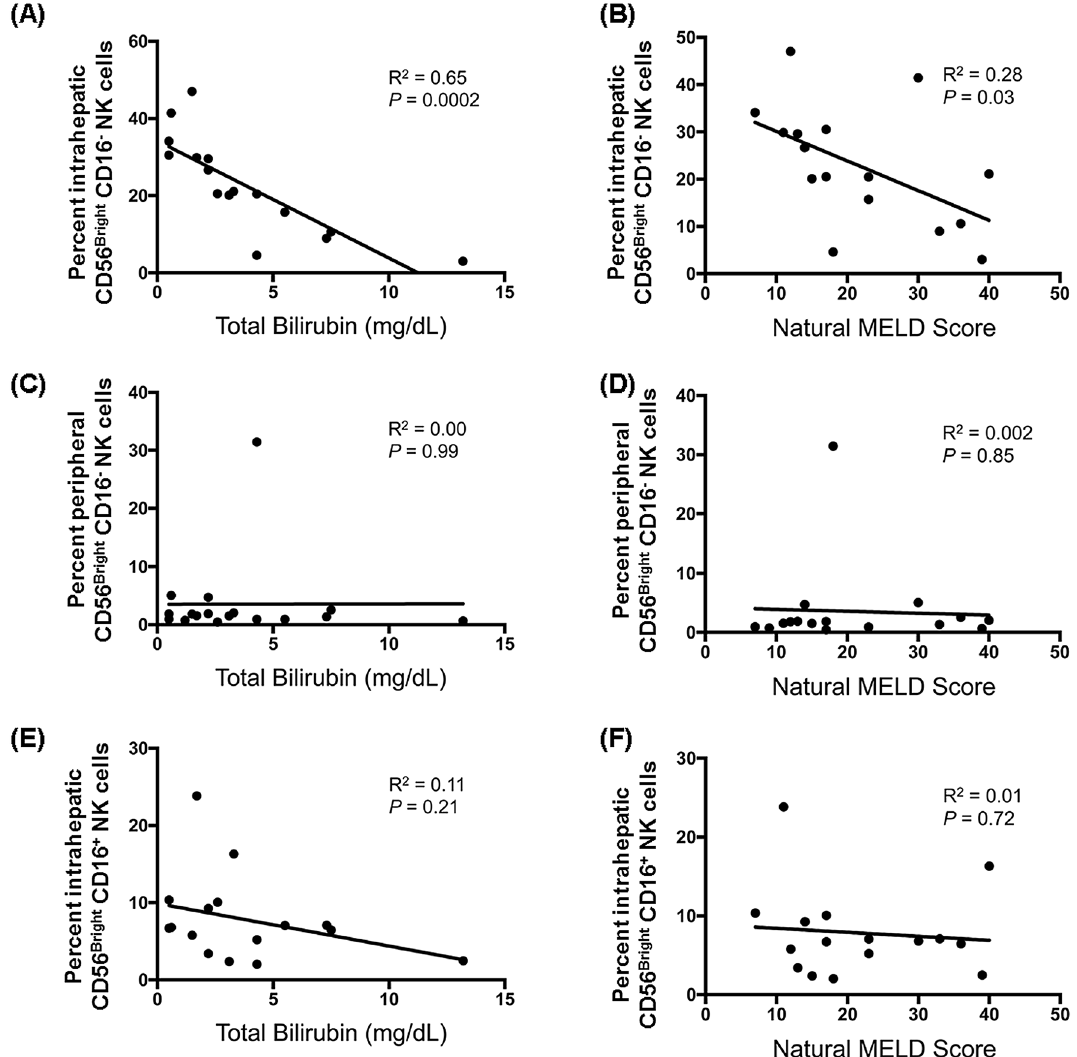
Figure 6. Correlation between the abundance of liver resident CD56 Bright CD16 - NK and better clinical status. The correlation between the abundance of hepatic CD56 Bright CD16 - NK cells and serum total bilirubin (A) and the natural MELD score calculated for the day of transplantation (B) . The correlation between the abundance of peripheral blood CD56 Bright CD16 - NK cells and serum total bilirubin (C) and the natural MELD score (D) . The correlation between the abundance of hepatic CD56 Bright CD16 + NK cells and serum total bilirubin (E) and the natural MELD score (F) . N = 16, calculated using the Pearson’s correlation